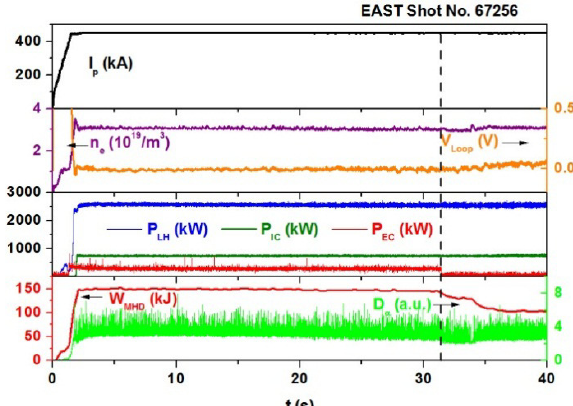
Fig. 16. Time evolution of key signals of the shot # 67256.